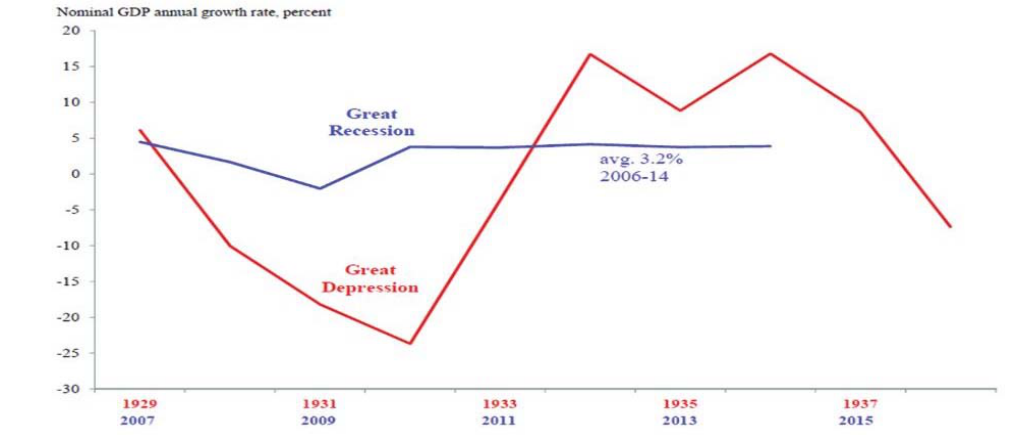
Fig. 2. Nominal GDP of the United States